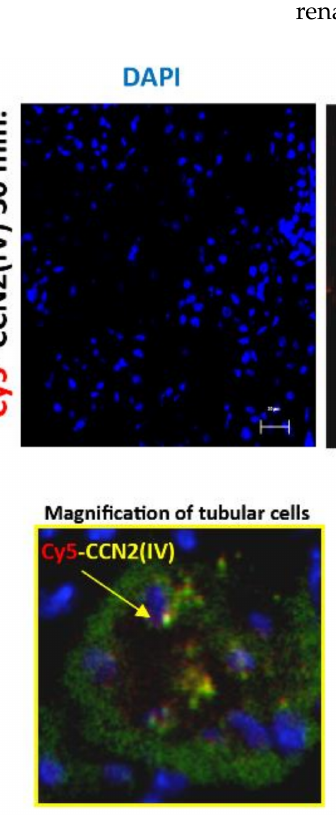
Figure 2. CCN2 (IV) binding was located in the tubuli but not in other renal structures in the kidney. Mice were injected with Cy5-CCN2(IV) in the right kidney and studied 30 min later. Red immunostaining was only found in the tubuli but was not present in the glomeruli. Renal tissue autofluorescence (green) and DAPI staining (blue) show renal structures. The overlaid images indicate CCN2(IV) localization only in the tubuli. Figures show a representative mouse per group, and scale bar represents 20 µ